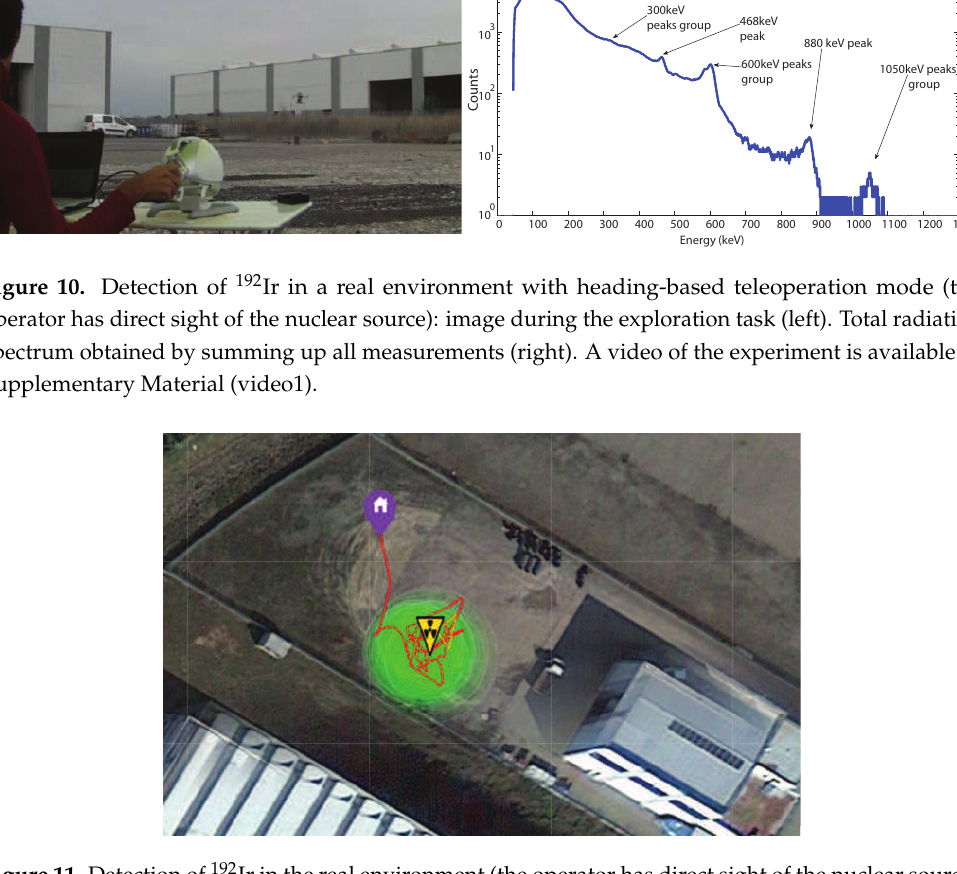
Figure 11. Detection of 192 Ir in the real environment (the operator has direct sight of the nuclear source): flight path of the experiment shown in Figure 10; regions where radiation was measured by the CdZnTe detector (green circles with different sizes and shading) and the estimated location of the maximum radiation (apex of the yellow